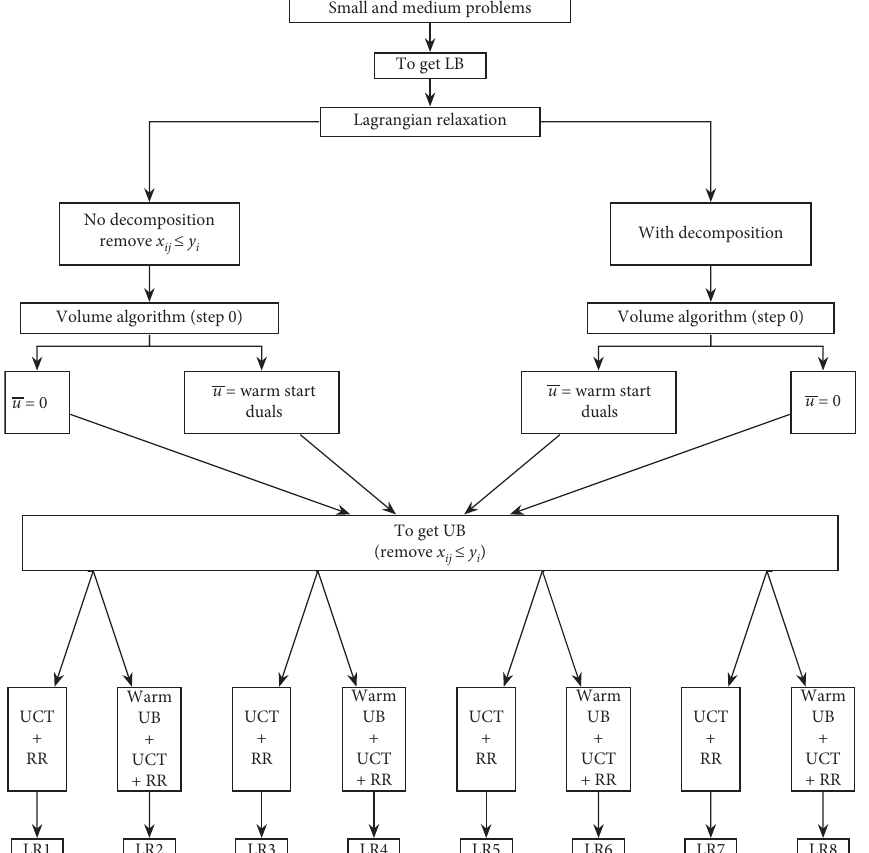
Figure 1: The Lagrangian heuristics and the volume algorithm’s methods LR1–LR8. Table 1: A comparison between the results of the LR and VA and the LD and VA for the small problems sized 100–300. Problem size m ×